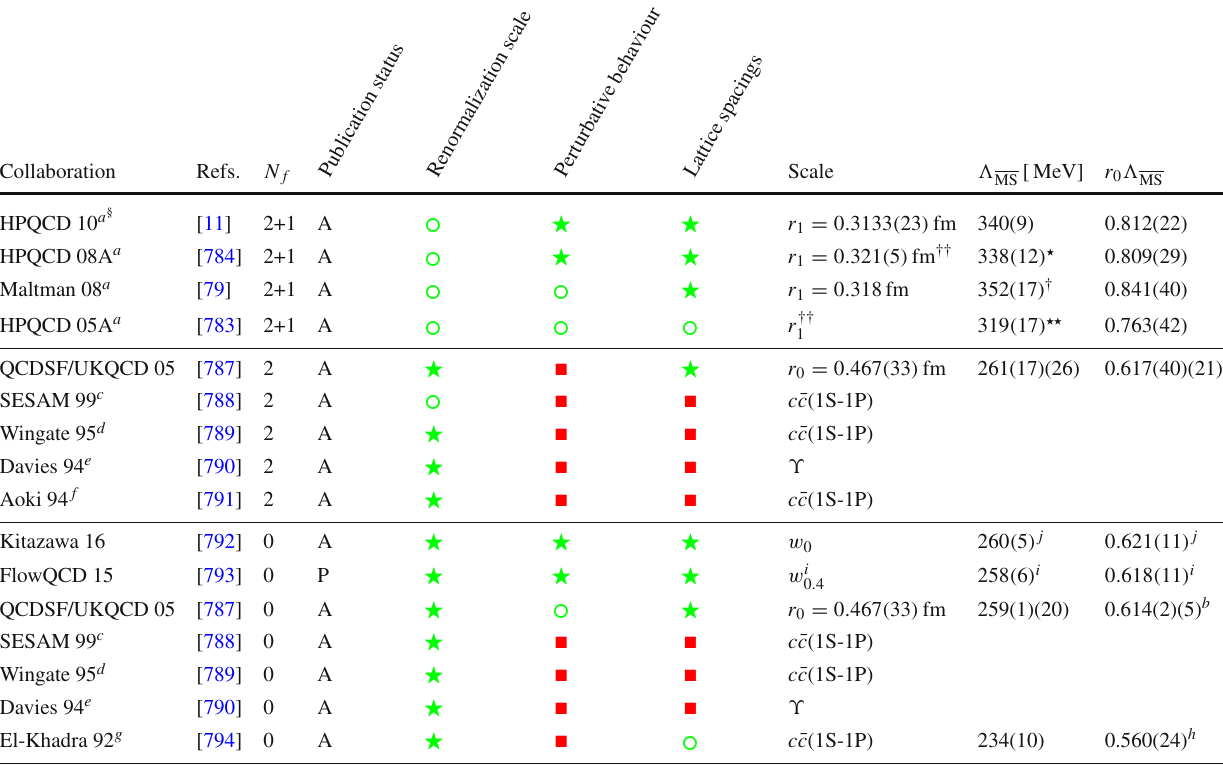
Table 63 Wilson loop results. Some early results for N f = 0 , 2 did not determine (cid:8)